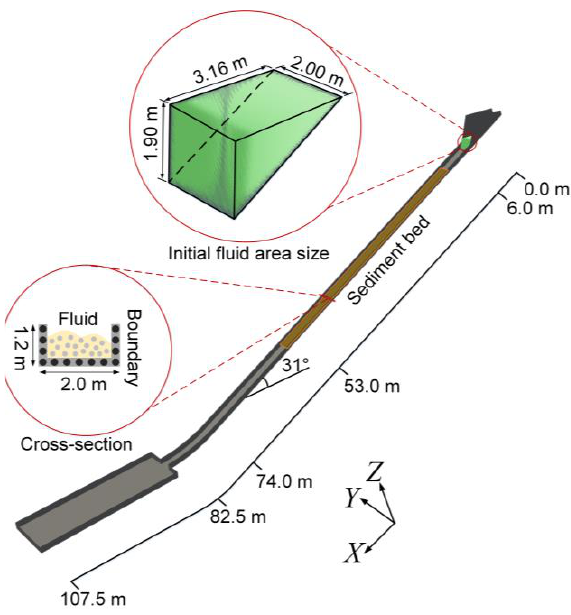
Figure 2. Numerical model for debris flow flume test.